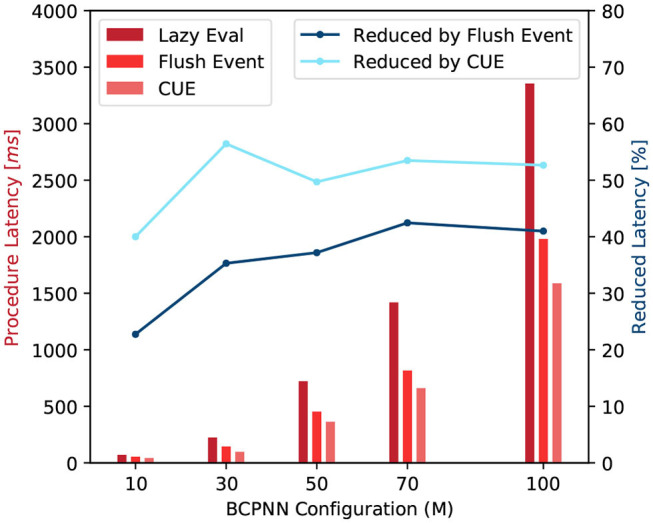
Latency comparison of synaptic matrix update procedures (red) and latency reduction by flushing event method and CUE method (blue).